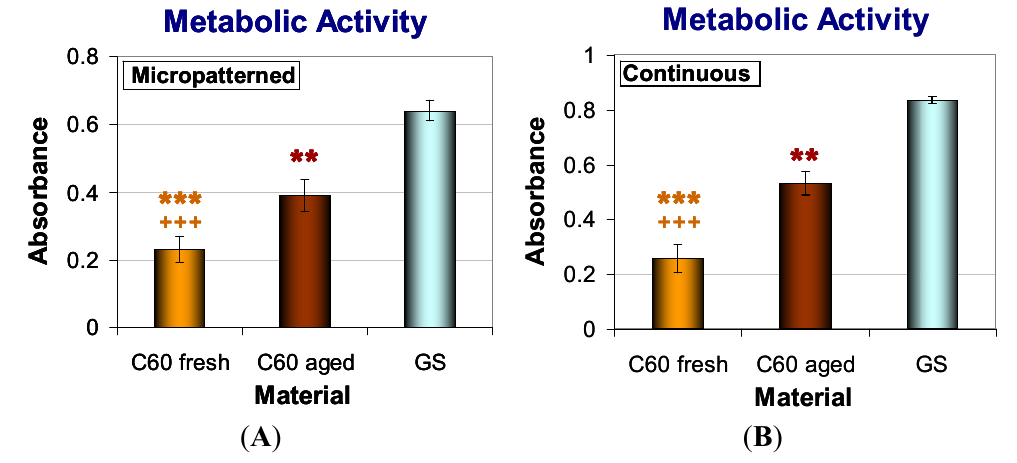
Figure 10. Metabolic activity measured per cultures of human osteoblast-like MG-63 cells on day seven after seeding on micropatterned ( A ) or continuous ( B ) fresh and aged fullerene films. GS, microscopic glass coverslips, reference material; * significant difference to GS; + significant difference to C aged. p ≤ 0.001 ( *** /+++); p ≤ 0.01 ( ** /++). 60